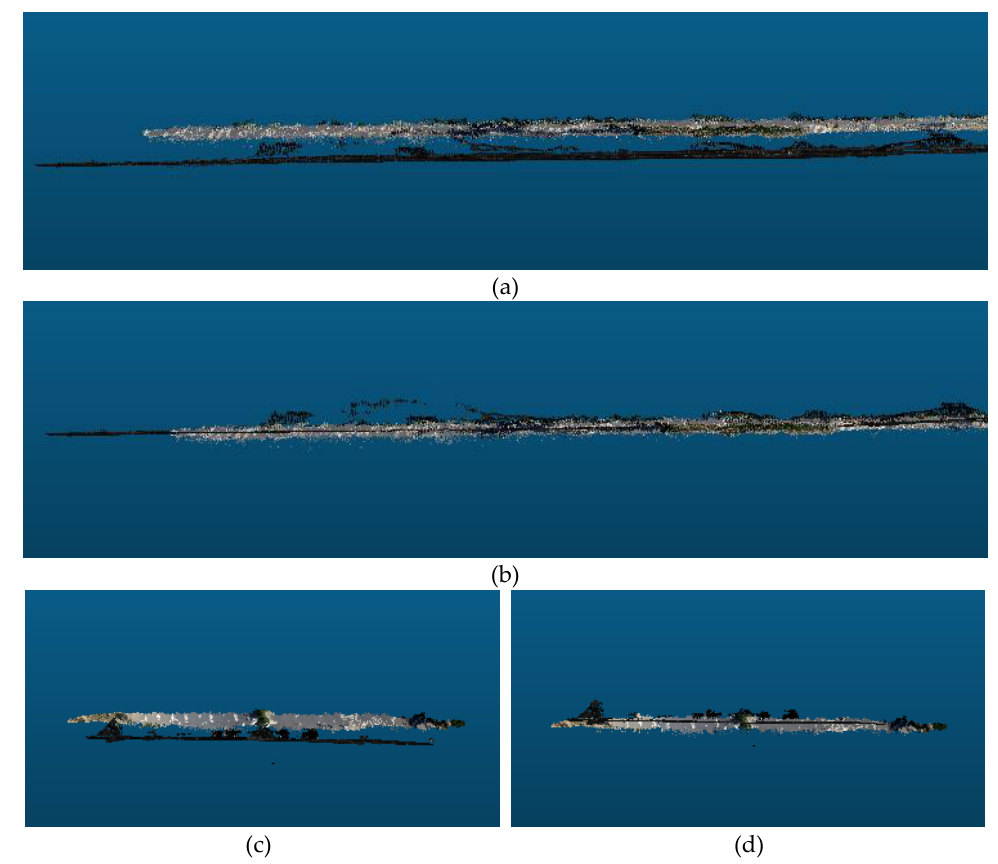
Figure 9. Vehicle-borne LiDAR and image-dense point cloud: (a) Longitudinal section before LiDAR constrain; (b) longitudinal section after LiDAR constrain; (c) transverse section before LiDAR constrain; (d) transverse section after LiDAR constrain.